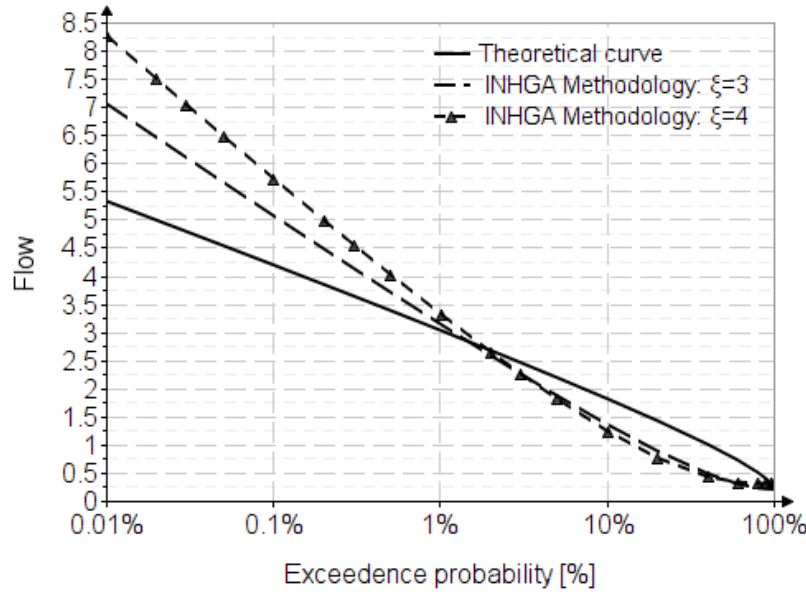
Figure 3. The theoretical curve PE3 and the curves from the INHGA methodology. The quantile for L-moments, expressed with the frequency factor, has the following expression: where, K p ( p, α , .. ) = f ( τ 3 ) . The best fit distribution for L-moments is based on the statistical indicator recom- mended by [8,13], and the graph of variation between skewness and kurtosis is obtained based on L-moments, presented in Appendix